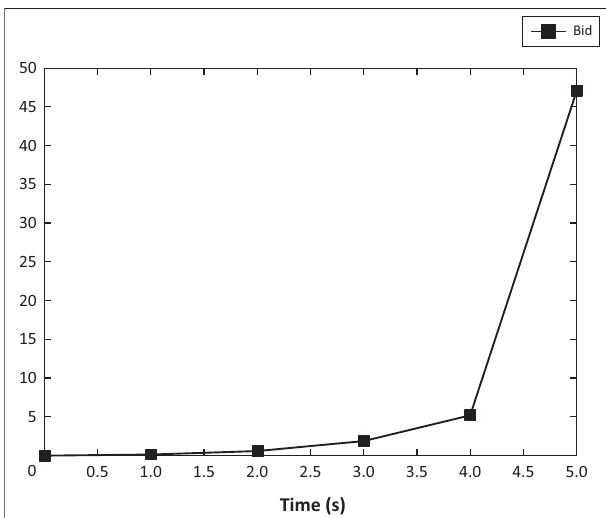
FIGURE 7: Plot of B